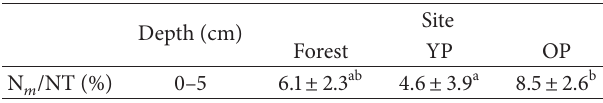
Table 10: Percentage of the mineralized N accumulated in relation to total nitrogen soil in forest and